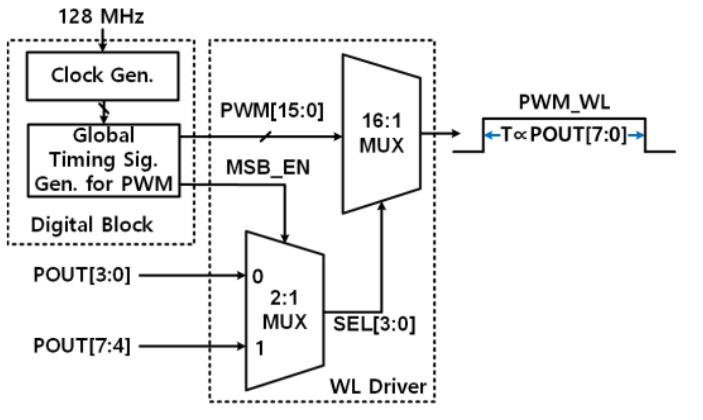
Figure 7. PWM conversion circuit.